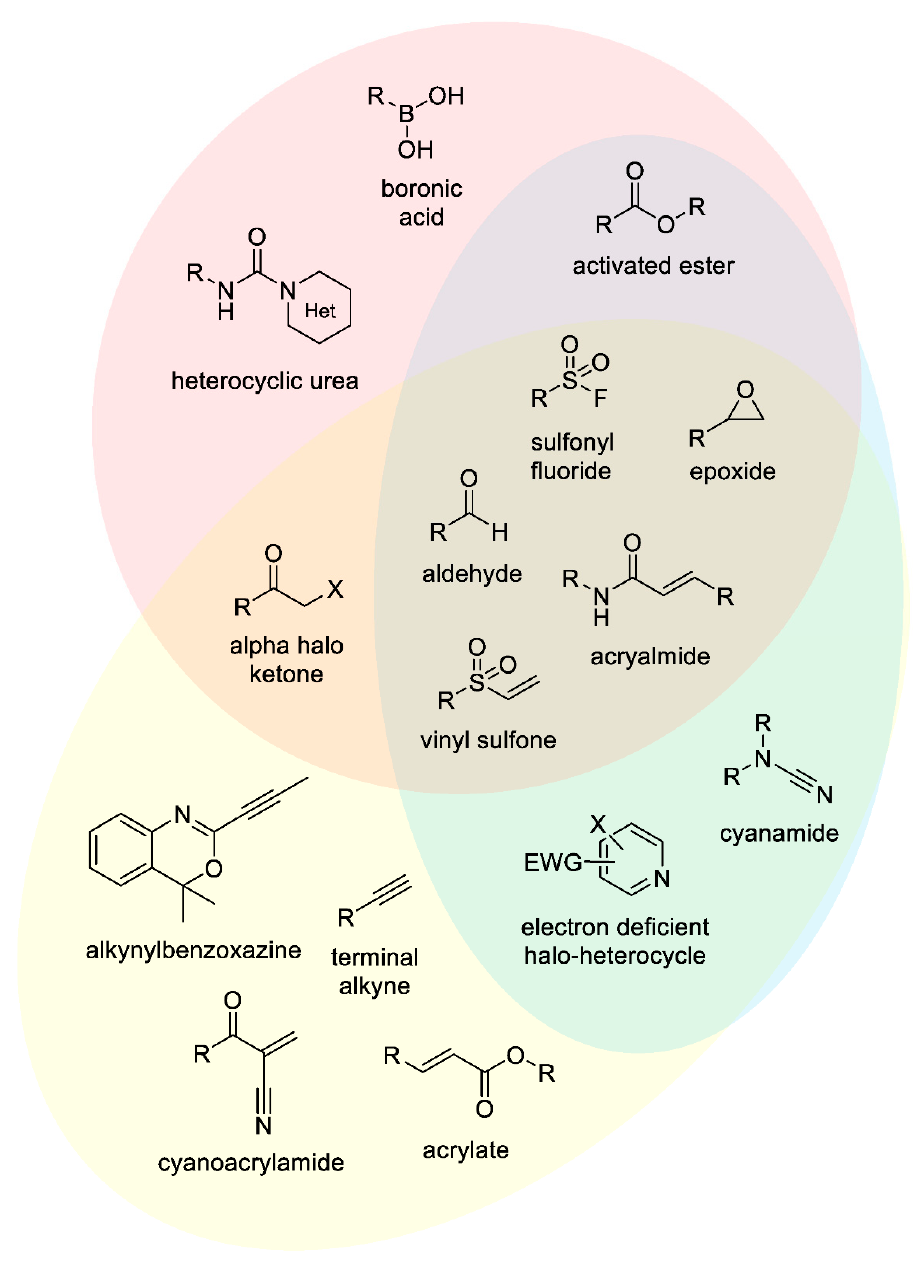
Figure 2. Representative warhead motifs and overlap of amino acid activity. Colours represent selected amino acids which have been labelled in the literature by those warheads; yellow—cysteine, blue—lysine, red—serine/threonine. Where overlap occurs the corresponding secondary colour is observed [14,36].